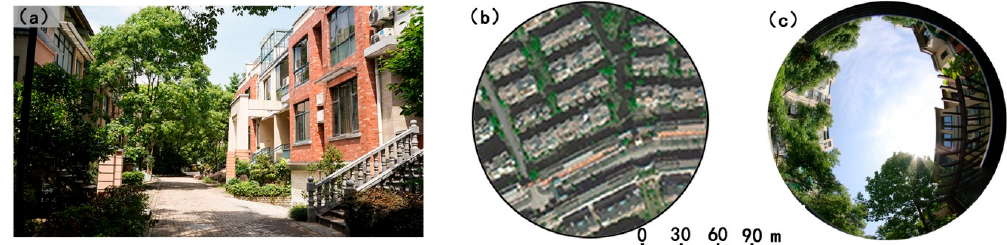
Figure 2. Landscape features of one measurement point (ZJ1). ( a ) Site photograph, ( b ) land cover features in the buffer zone, and ( c ) fish-eye photograph.